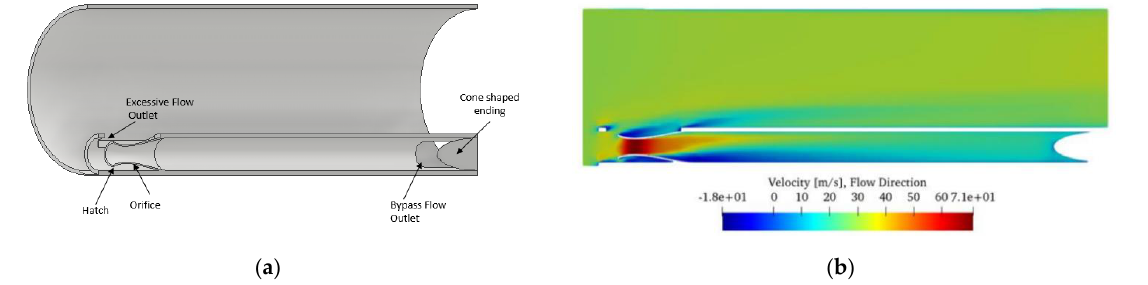
( b ) Figure 4. ( a ) test design concept (2) 3D, mid-section; ( b ) test design concept (2) simulation result. Summarizing the obtained CFD simulation results for test designs (1) and (2), we noticed that a high circulating flow was present (dark-blue areas at Figures 3b and 4b), while the velocity varied significantly throughout the bypass pathway.